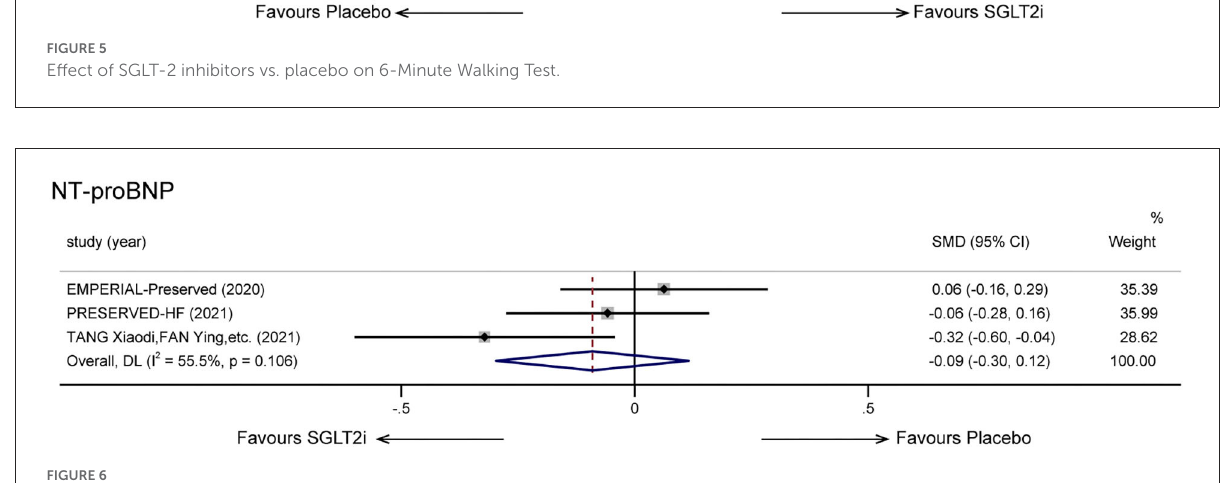
FIGURE6 Effect of SGLT-2 inhibitors vs. placebo on